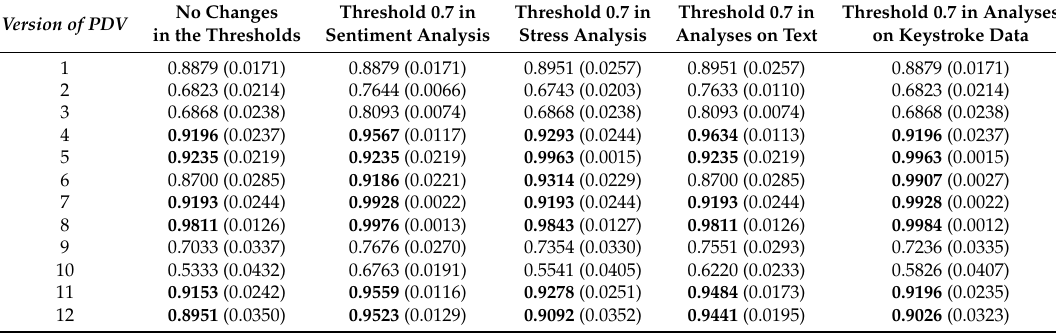
Table 2. Mean and standard error (in parenthesis) for the different versions of PDV in the